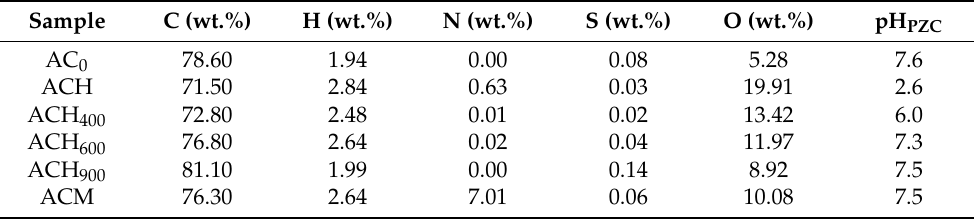
Table 3. Elemental analysis and pH PZC values of the modified activated carbons.